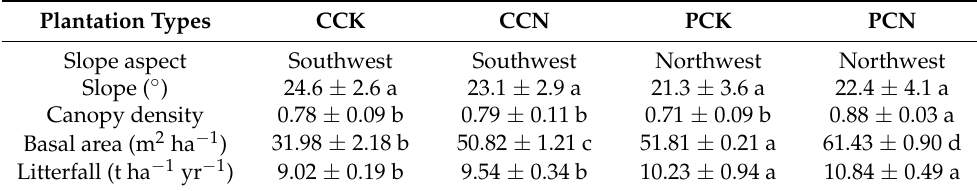
Table 1. The stand characteristics in four plantations measure in August 2018. Plantation Types CCK CCN PCK PCN Slope aspect Southwest Southwest